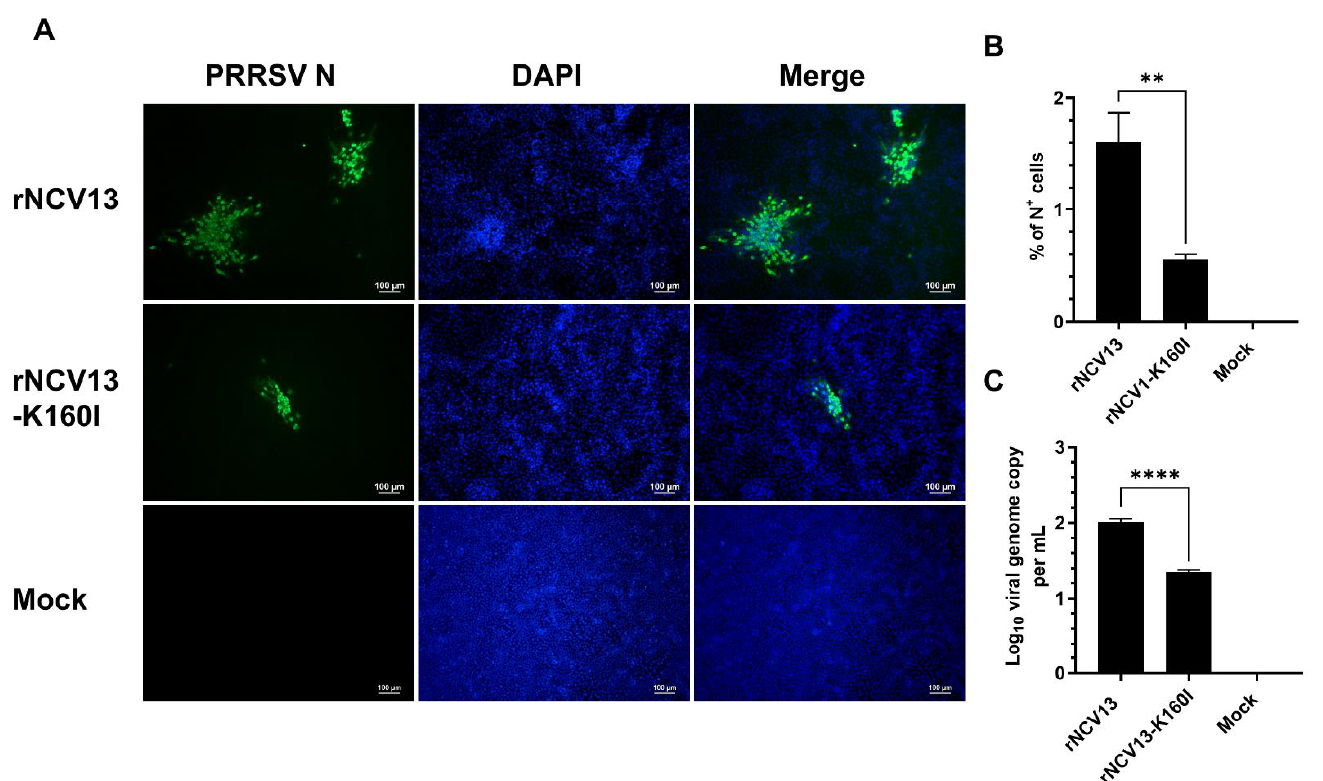
Figure 9. Infectivity of rNCV13 strain and its derived mutant in PK15-pCD163. PK15 cells stably expressing porcine CD163 (PK15-pCD163) cells were inoculated with the indicated viruses at an MOI of 1. Data were collected at 72 hpi. ( A ) Representative images of cells that were fixed and stained with an anti-N antibody to visualize virus-infected cells (green color). DAPI was used to stain the nuclei (blue color). Scale bar = 100 µ m. ( B ) Percentage of cells expressing N protein as quantified by flowcytometry. ( C ) Difference of viral genome copy numbers in the culture supernatants collected at 0 hpi and 72 hpi as quantified by RT-qPCR. Data are presented as means and SEM of the three independent experiments. ** p < 0.01, **** p < 0.0001.